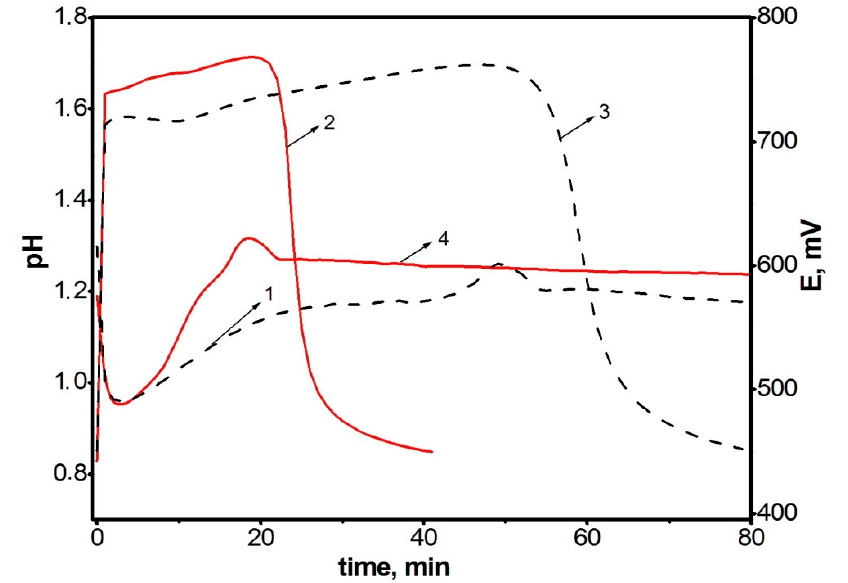
Figure 1. Time dependences of changes in pH (curves 1 and 2) and redox potential (curves 3 and 4) at the oxidation of aniline (curves 1 and 3) and DADCB (curves 2 and 4). Standard conditions.